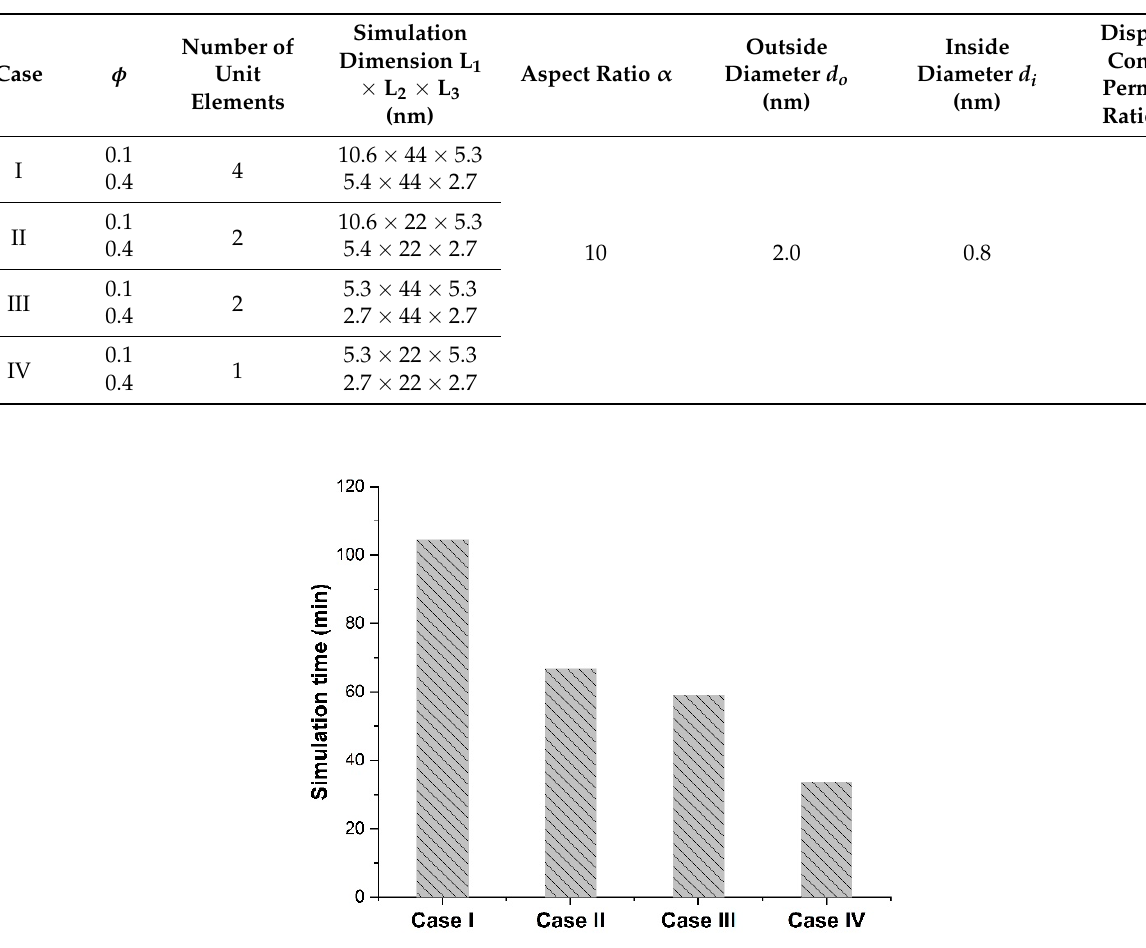
Figure 4. Computation times of the numerical simulations for the four different case studies using one core and 1 Gb RAM on the Frontenac cluster nodes available at the Centre for Advanced Computing (CAC) at Queens University (Canada).